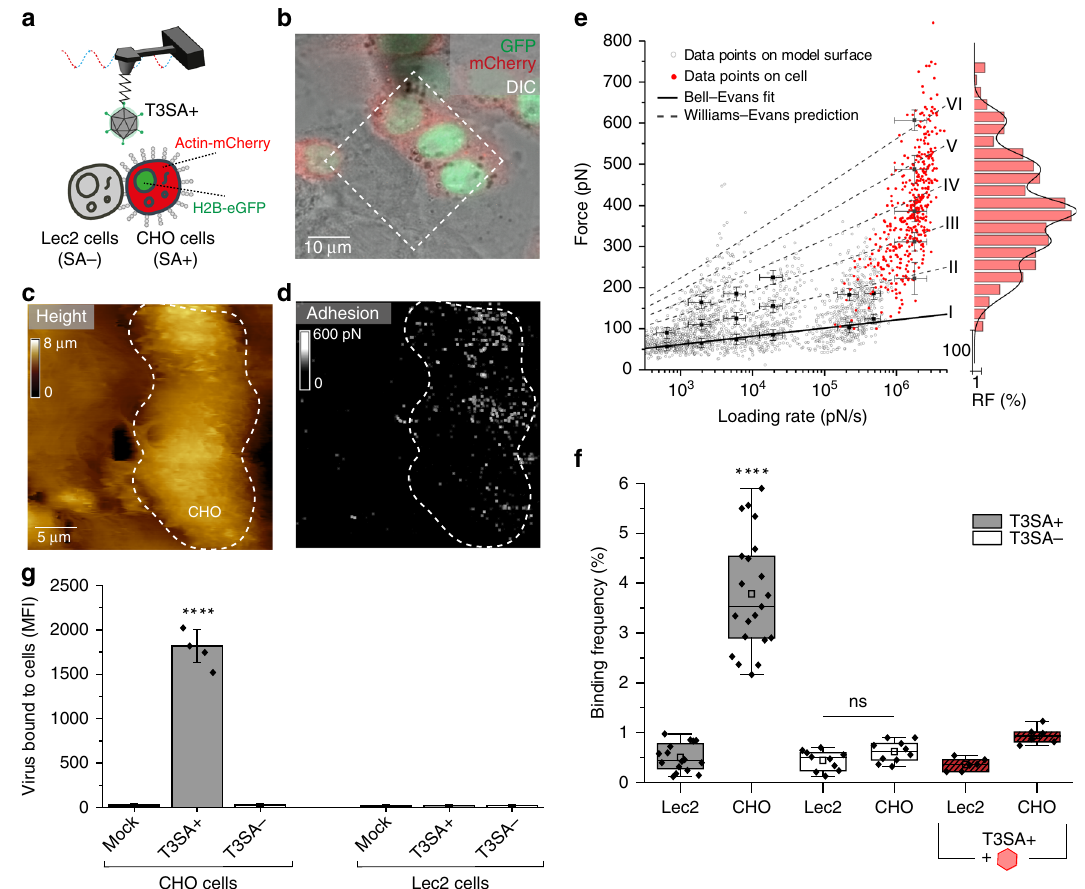
Fig. 3 Probing T3 reovirus binding to sialylated glycans on living cells. a Combined optical microscopy and FD-based AFM of T3SA + binding to cells expressing (CHO) or lacking (Lec2) α -SA on the cell surface. b Overlay of DIC, eGFP, and mCherry signals of a con fl uent layer of co-cultured fl uorescent CHO cells (actin-mCherry and H2B-eGFP) and Lec2 cells. c, d FD-based AFM topography image ( c ) and corresponding adhesion map ( d ) from probing of adjacent cells indicated in the dashed square in b . The adhesion map shows interactions mainly on CHO cells ( α -SA-expressing cells) (white pixels). For higher visibility, the pixel size in the adhesion image was enlarged two-fold. e DFS plot of data from α -SA model surfaces (grey circles, from Fig. 2c) and living cells (red dots). Histogram of the force distribution observed on cells fi tted with a multi-peak Gaussian distribution ( n = 700 data points) is shown at the side. f Box plot of BF observed for T3SA + (gray) and T3SA − (white) virions as well as T3SA + virions following injection of 1 mM Neu5Ac (red). The horizontal line within the box indicates the median, boundaries of the box indicate the 25th and 75th percentile, and the whiskers indicate the highest and lowest values of the results. The square in the box indicates the mean. For all experiments, data are representative of at least n = 5 independent experiments. g In fl uence of SA on virus binding determined by fl ow cytometry. Cells were incubated with either PBS (Mock) or Alexa Flour 488-labeled T3SA + or T3SA − virions (10 5 particles per cell), and the median fl uorescence intensity (MFI) of cell-bound virus was determined by fl ow cytometry as shown in Supplementary Fig. 3a. Error bars indicate s.d. of the mean value. Experiments were repeated twice ( n = 2 independent experiments, each with duplicate samples). ns, P > 0.05; **** P < 0.0001; determined by two-sample t -test in Origin ( f ) and by two-way ANOVA corrected for multiple comparisons using Tukey ’ s test in GraphPad Prism ( g ), respectively. Source data are provided as a Source Data fi